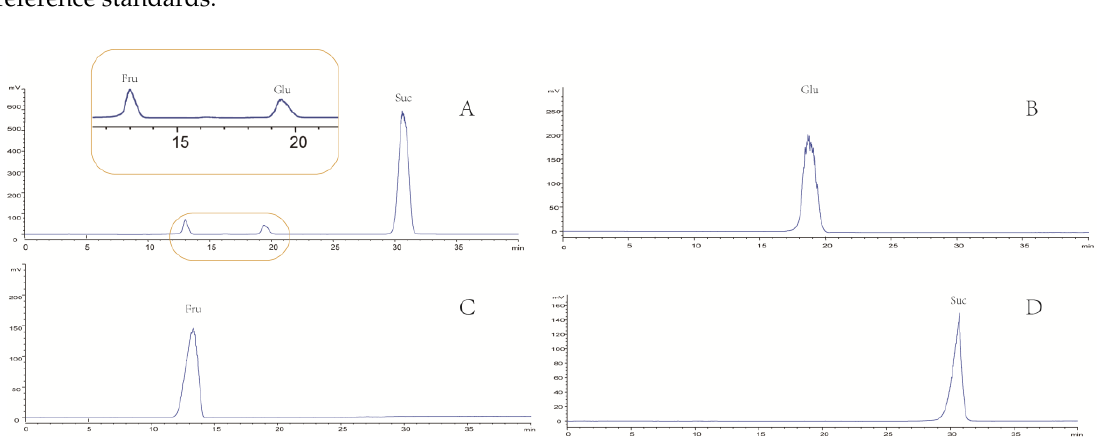
Figure 2. Comparative analysis of WLJHT ( A ) and 3 saccharides ( B : Glucose; C : Fructose; D : Sucrose) using HPLC-ELSD couple with a Hilic column.